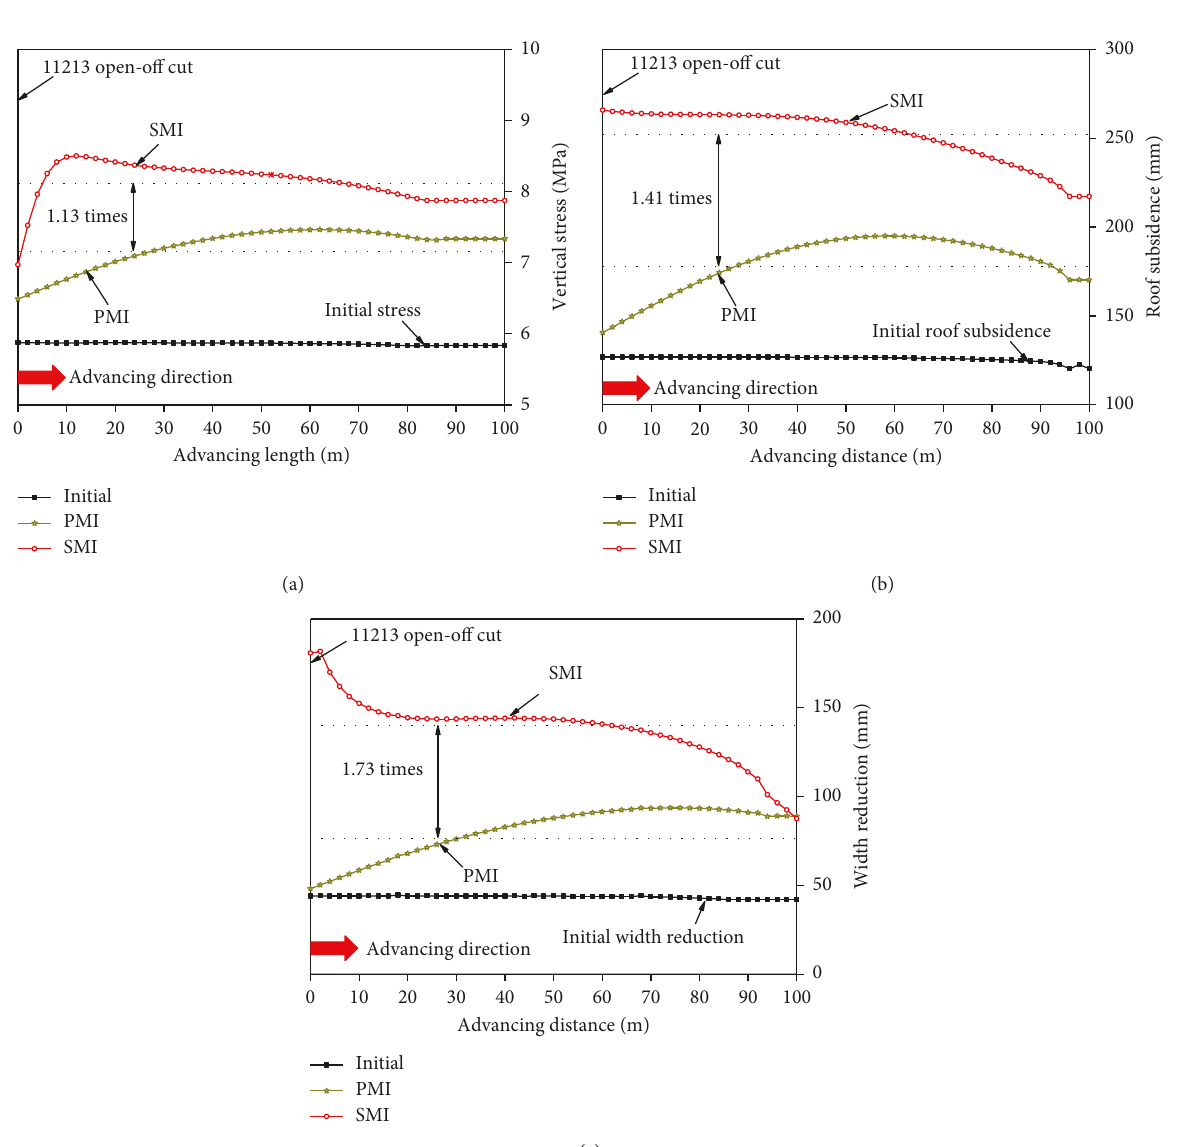
Figure 15: Characteristics of 11215 tailentry under PMI and SMI. (a) Roof stress. (b) Roof subsidence. (c) Width reduction.